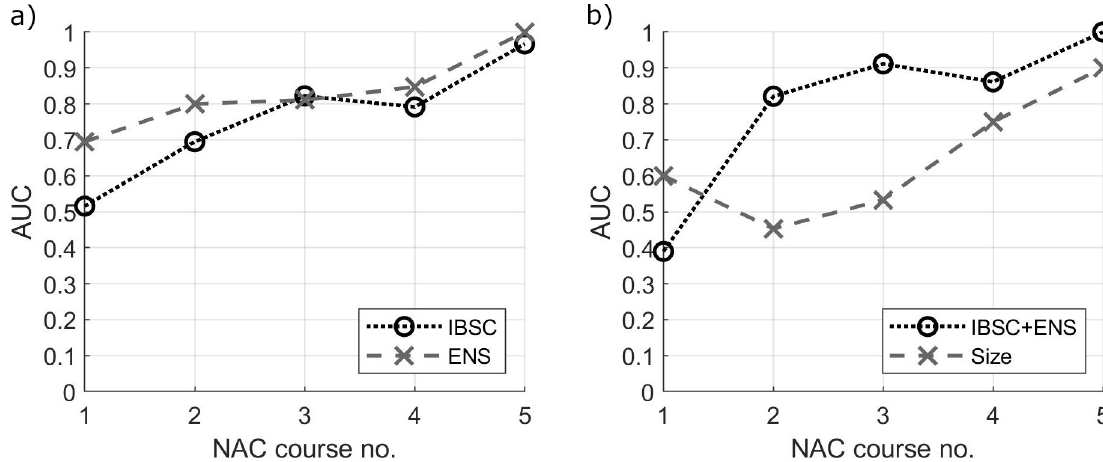
Fig 6. Area under the ROC curve (AUC) values for treatment response classification at each treatment stage. a) individual QUS parameters, IBSC and ENS and b) linear combination of IBSC and ENS (IBSC+ENS) and the largest tumor size.